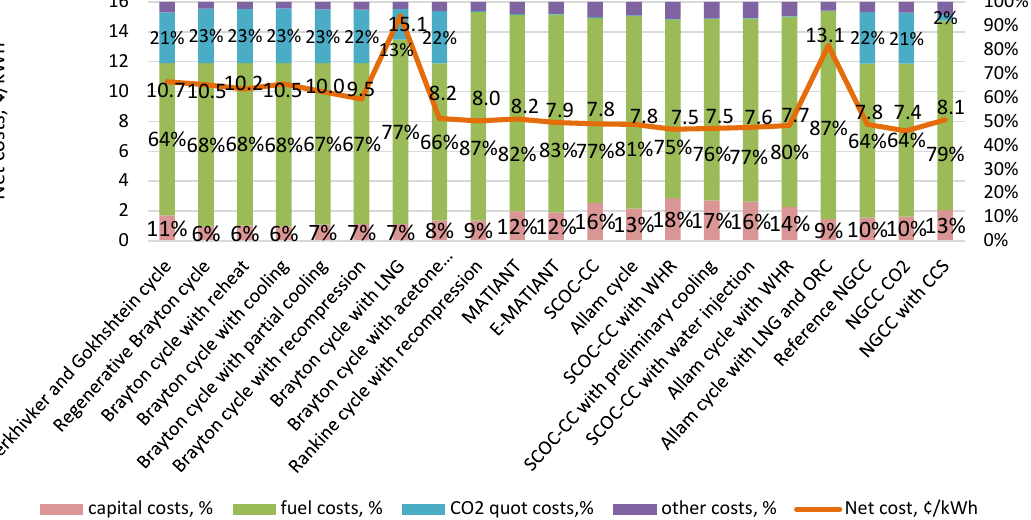
Figure 31. Cost of electric power generated with regeneration CO 2 power cycles in comparison with NGCC plants at the cost of CO 2 emission quotas of 50 $/ton for large-capacity power cycles. Figure 32 shows a diagram of the cost of various high-capacity CO 2 power cycles in